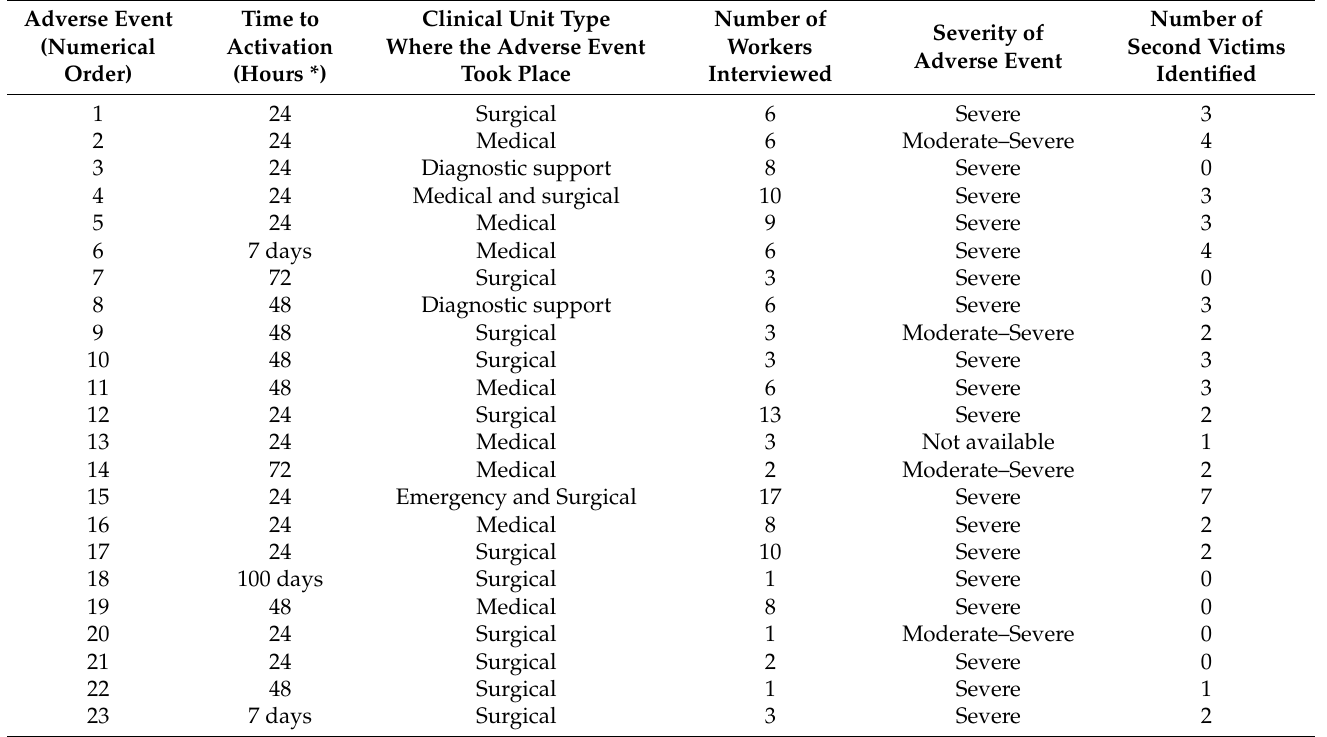
Table 1. Features of the procedure for Serious Adverse Events activated during the study